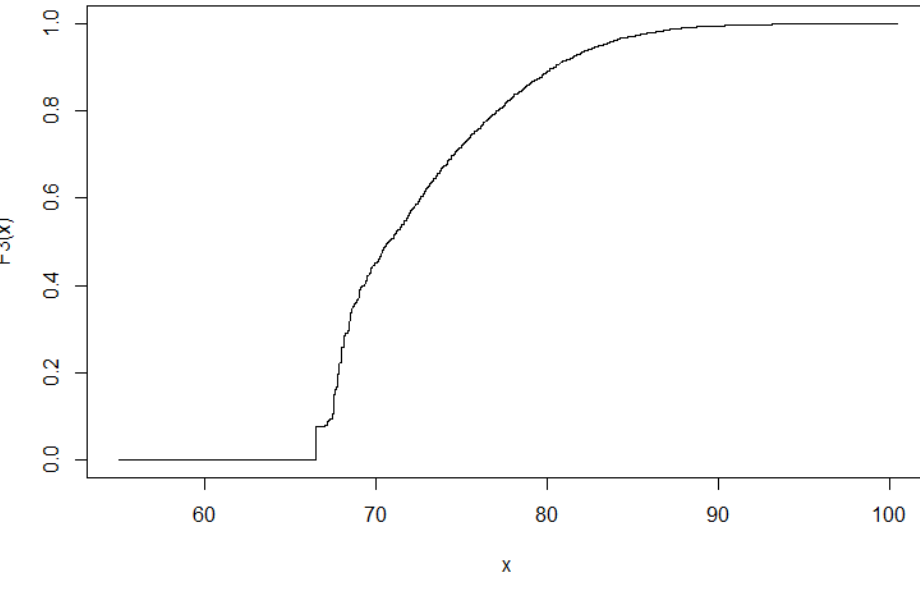
Figure A6. The F 3 bid distribution, source: own